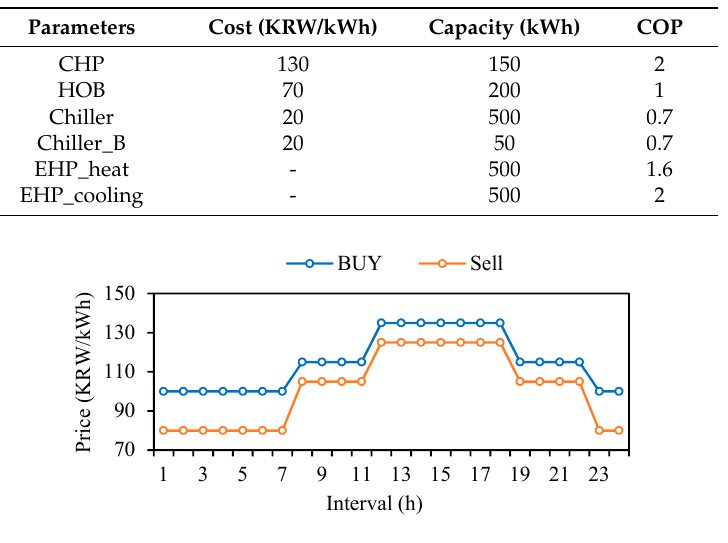
Figure 8. Interaction among different agents. Table 1. Input parameters for energy supply facilities. Table 2. Battery energy storage system (BESS) and thermal energy storage system (TESS)